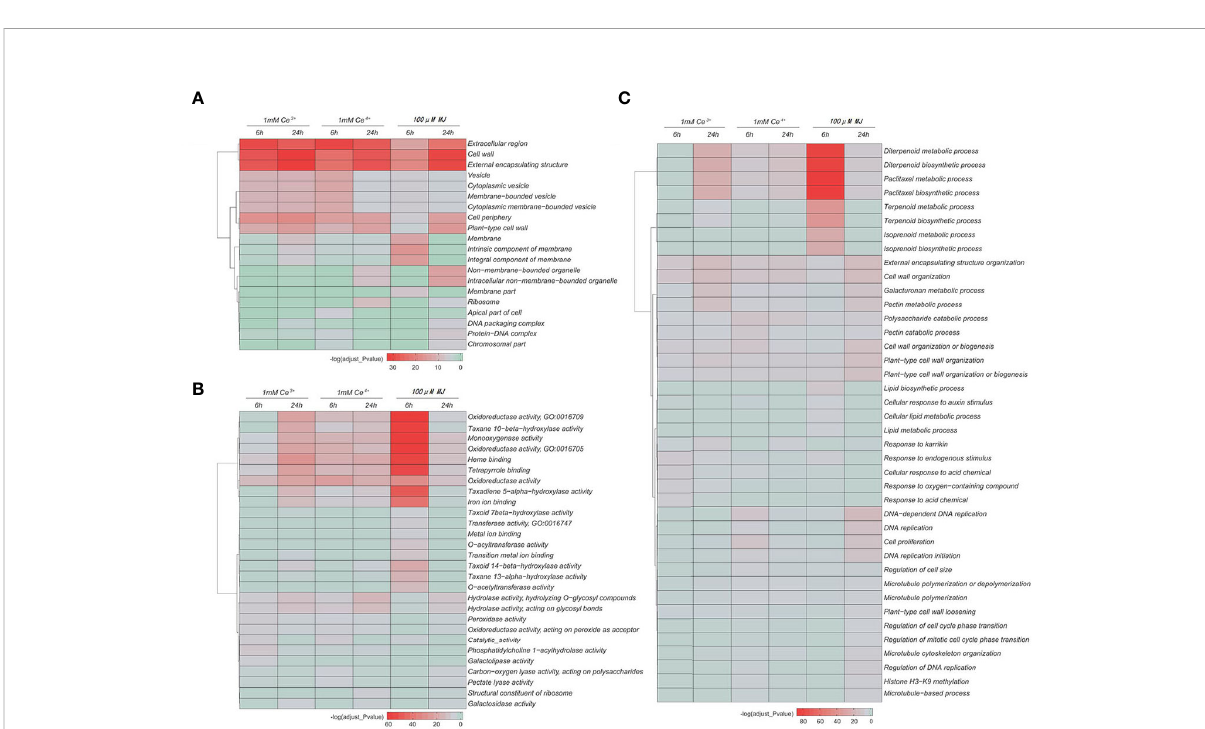
FIGURE 5 GO enrichment analysis of the DEGs in the six comparisons. (A) Cell composition (B) Molecular function (C) Biological process. The color indicates the signi fi cance level.